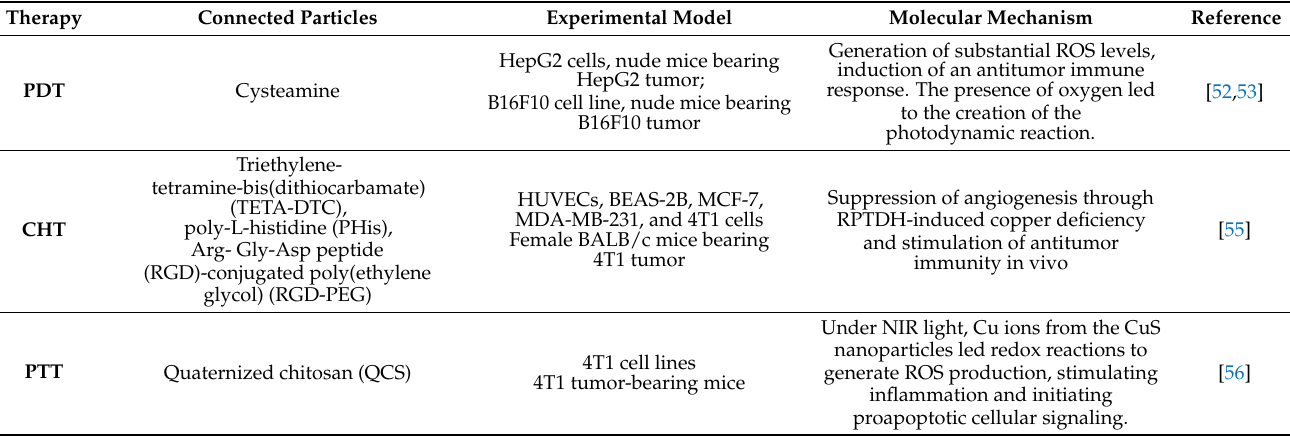
Table 5. Selected connections of biologically active molecules with copper